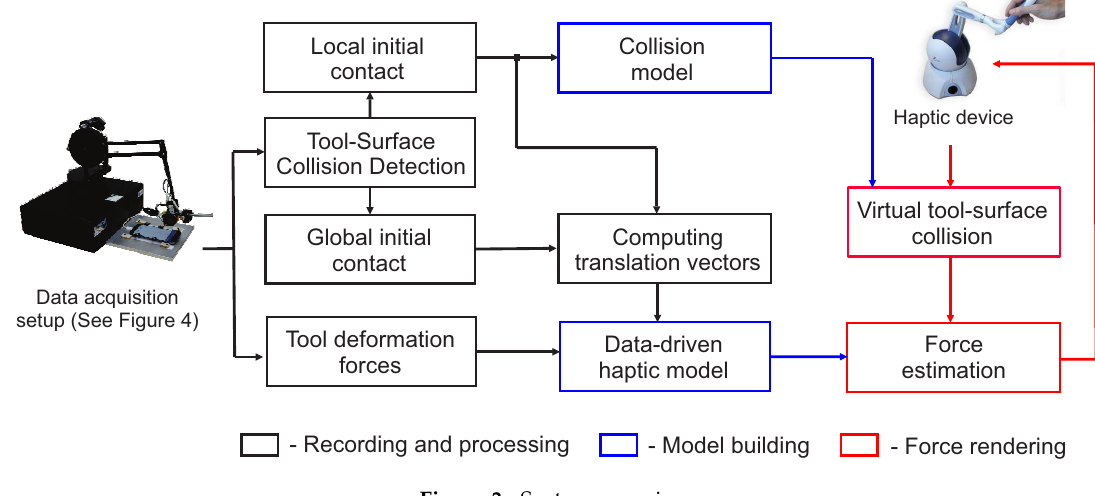
Figure 3. System